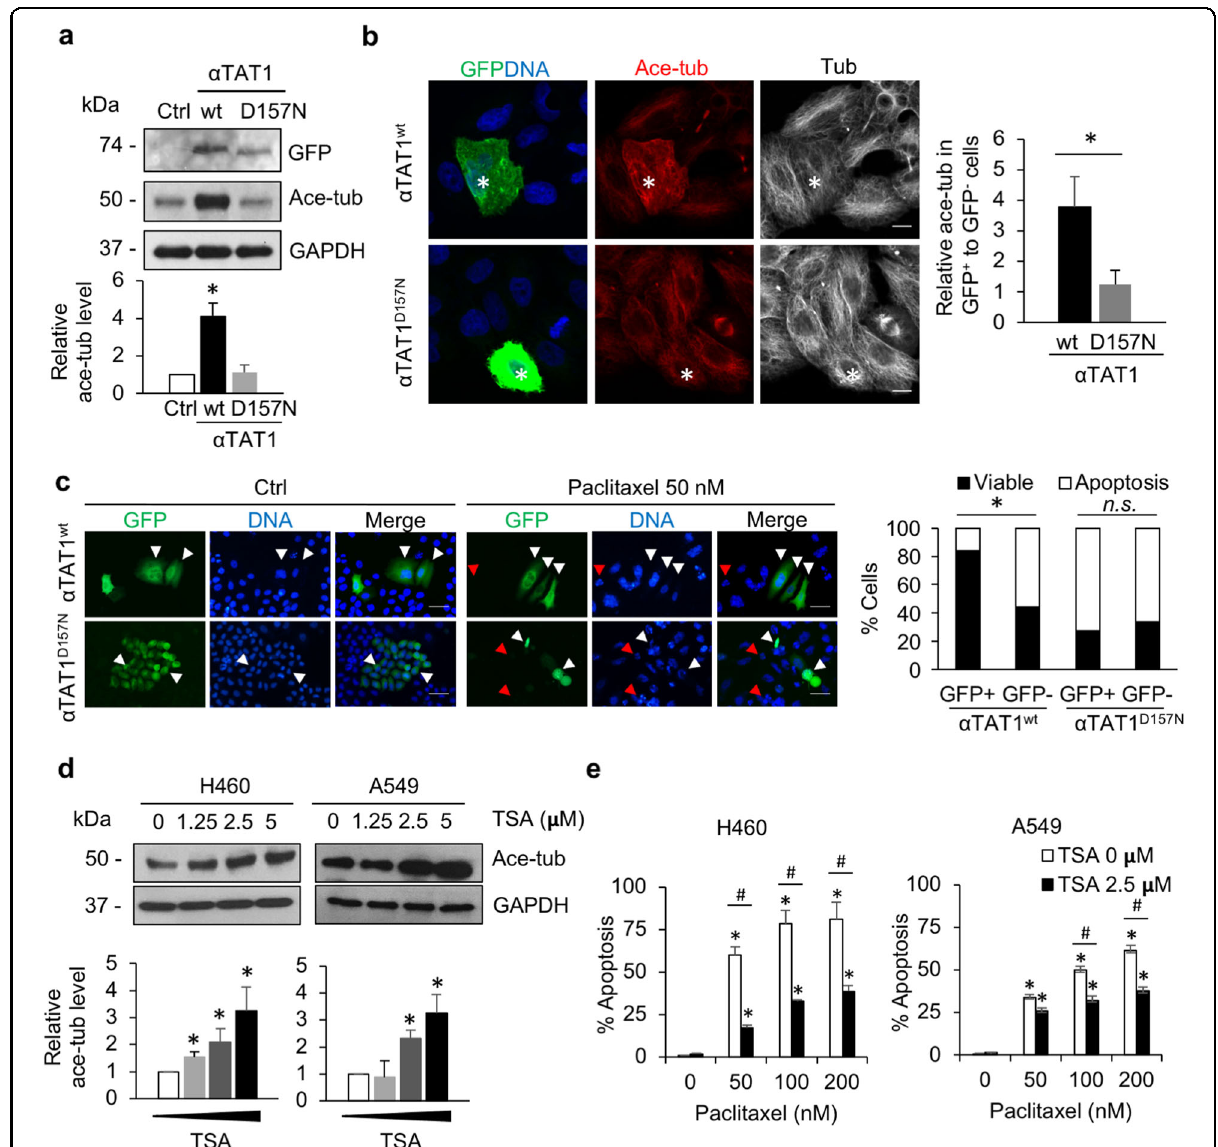
Fig. 4 Overexpression of tubulin acetylation mediates apoptotic resistance to paclitaxel. a H460 cells were transfected with either GFP-tagged α -tubulin N-acetyltransferase 1 wild-type (GFP- α TAT1 wt ) or its dominant-negative mutant (GFP- α TAT1 D157N ) plasmid. GFP and tubulin acetylation expression was examined by western blot analysis. The blots were reprobed with GAPDH to con fi rm equal loading. The graph shows the mean ± SEM of the relative acetylated tubulin (Ace-tub) intensity. Student ’ s t test, * P < 0.05 vs mock control H460 (H460/Ctrl) cells ( n = 3). b Cells were immunostained for GFP (green), DNA (blue), acetylated tubulin (Ace-tub; red), and tubulin (gray), and imaged by confocal microscopy. The plot shows the ratio of acetylated tubulin intensity in GFP-positive (asterisk) to GFP-negative cells. Student ’ s t test, * P < 0.05 vs H460/GFP- α TAT1 wt cells, n = 25 cells. Scale bars: 10 μ m. c GFP-tagged α -tubulin N-acetyltransferase 1 wild-type (GFP- α TAT1 wt ) or its negative mutant (GFP- α TAT1 D157N )- transfected H460 cells were treated with 50 nM paclitaxel for 48 h, and GFP and apoptotic nuclei were imaged by fl uorescence microscopy. White arrowheads indicate the nuclei of GFP-positive cells, whereas the red arrowhead indicates those of GFP-negative cells. Scale bars: 50 μ m. The graph shows the percentage of apoptotic and viable cells in response to paclitaxel. Student ’ s t test, * P < 0.05 vs GFP-positive transfectants. n.s. not signi fi cant. d H460 and A549 cells were treated with trichostatin A (TSA) for 4 h, and tubulin acetylation levels were examined by western blot analysis. The blots were reprobed with GAPDH to con fi rm equal loading. The graph shows the mean ± SEM of the relative acetylated tubulin (Ace- tub) intensity. Student ’ s t test, * P < 0.05 vs nontreated cells ( n = 3). e H460 and A549 cells were pretreated with or without TSA (2.5 μ M) for 4 h, and further incubated with paclitaxel (0 – 200 nM) for 48 h. Apoptotic cells were examined by Hoechst 33342 staining and visualized under a fl uorescence microscope. The graph shows the percentage of apoptotic cells ± SEM ( n = 3). Student ’ s t test, * P < 0.05 vs paclitaxel nontreated cells. # P < 0.05 vs TSA nontreated